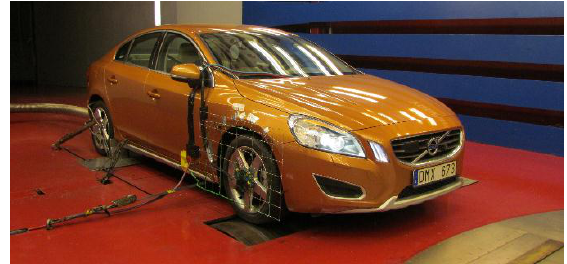
Figure 6. Test object during the wind tunnel braking investigation.